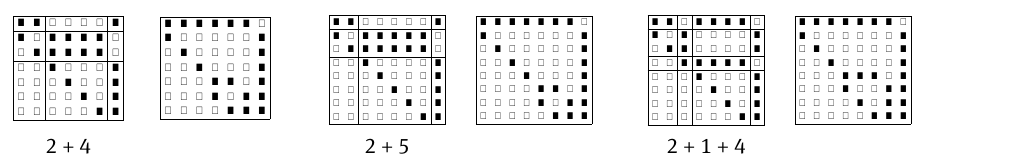
Figure 16: Upper Hessenberg matrices corresponding to integer compositions 2 + 4, 2 + 5 , and 2 + 1 + 4 . Next to them are depicted the corresponding minimal matrix